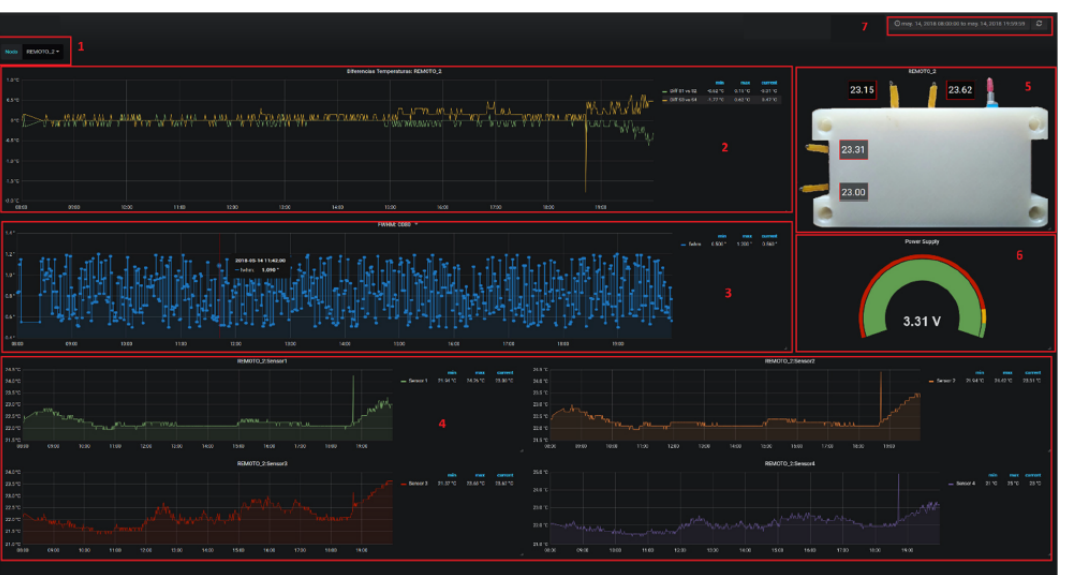
Figure 15. Grafana visualization example of nodes transmitted